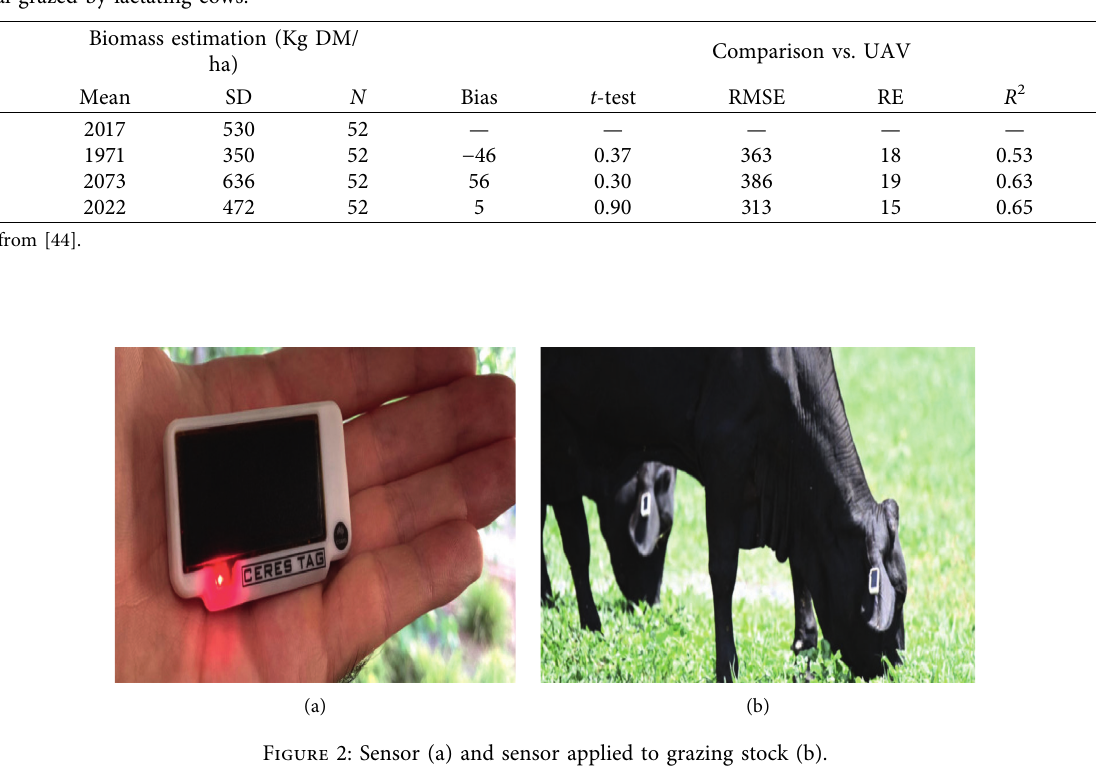
Figure 1: Example of the image analysis on a real image. Each pixel in the image is automatically analyzed and classified as either grass (blue), clover (red), weeds (yellow), or unidentified (black overlay). (a) Example input image. (b) Automatically analyzed image [21]. Table 2: Comparison of the UAV-based method for estimation of estimation of herbage mass for tall fescue and dry ryegrass-based pastures rotational grazed by lactating cows.